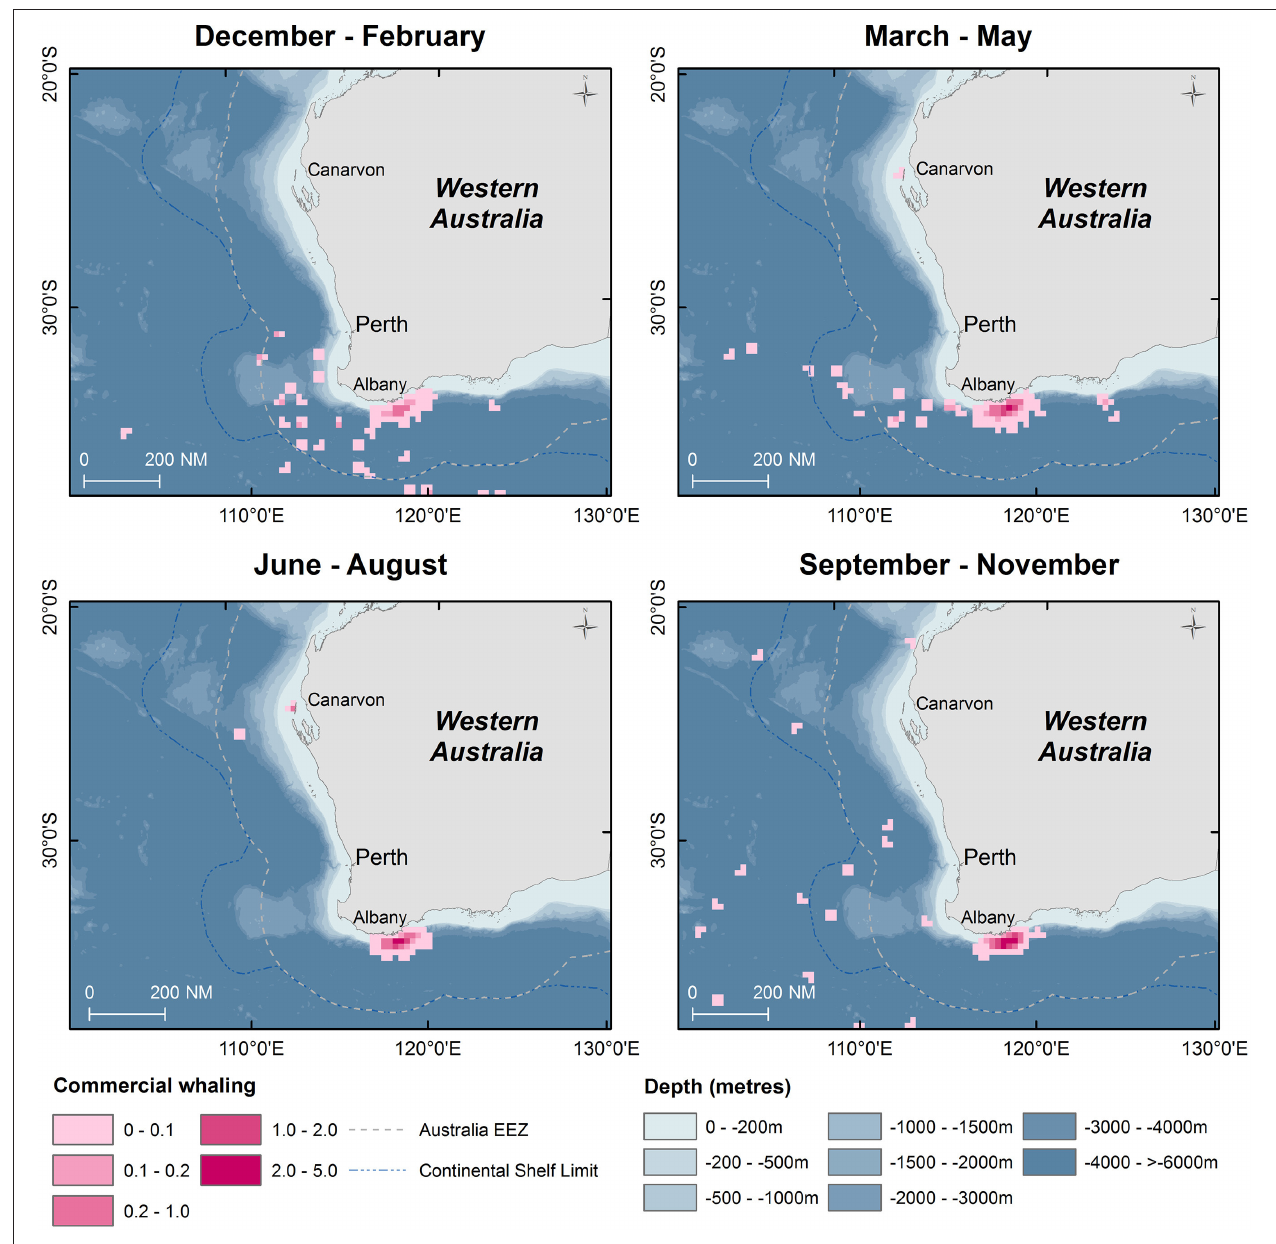
FIGURE 6 | Kernel density maps of seasonal distribution of sperm whale “takes” off Western Australia during the commercial whaling period (1936–1978). Data are shown by season in 15 nautical mile grid cells (Source: IWC).